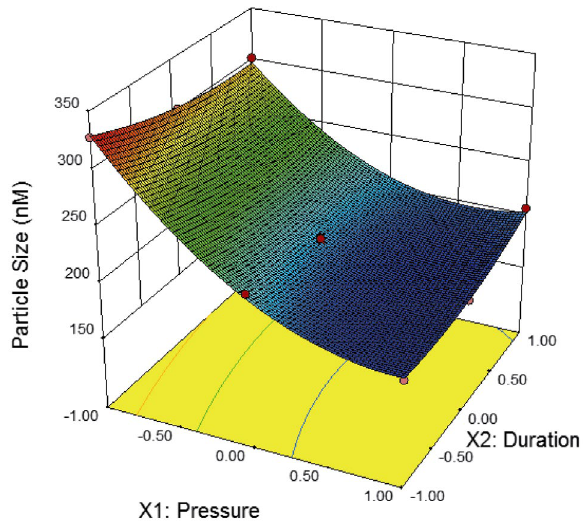
Figure 1. 3D Surface response plot indicates the effect of homogeni- zation pressure (X 1 ) and the duration of homogenization (X 2 ) on average particle size.